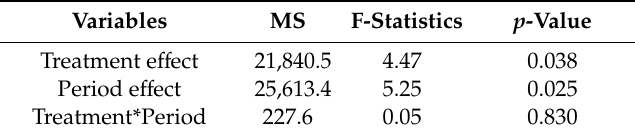
Table 4. E ff ects of intervention, its period e ff ect and period-by-treatment interaction on the timeliness in